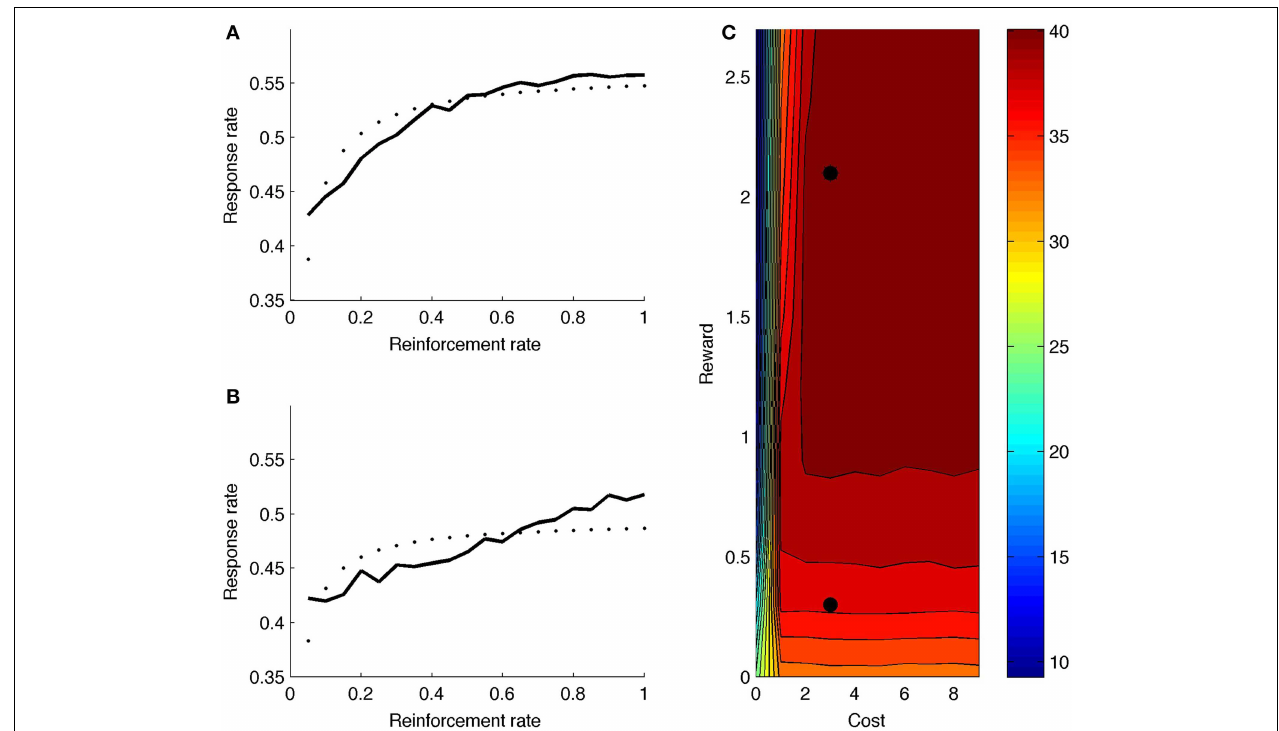
FIGURE 7 | (A) Response rate curve with reward rate = 2.1 (corresponding to upper black dot in C ). (B) Response rate curve with reward rate = 0.3 (corresponding to lower black dot in C ). (C) Mean number of runs for different reward and cost values. Dotted line is best-fitting hyperbolic curve.